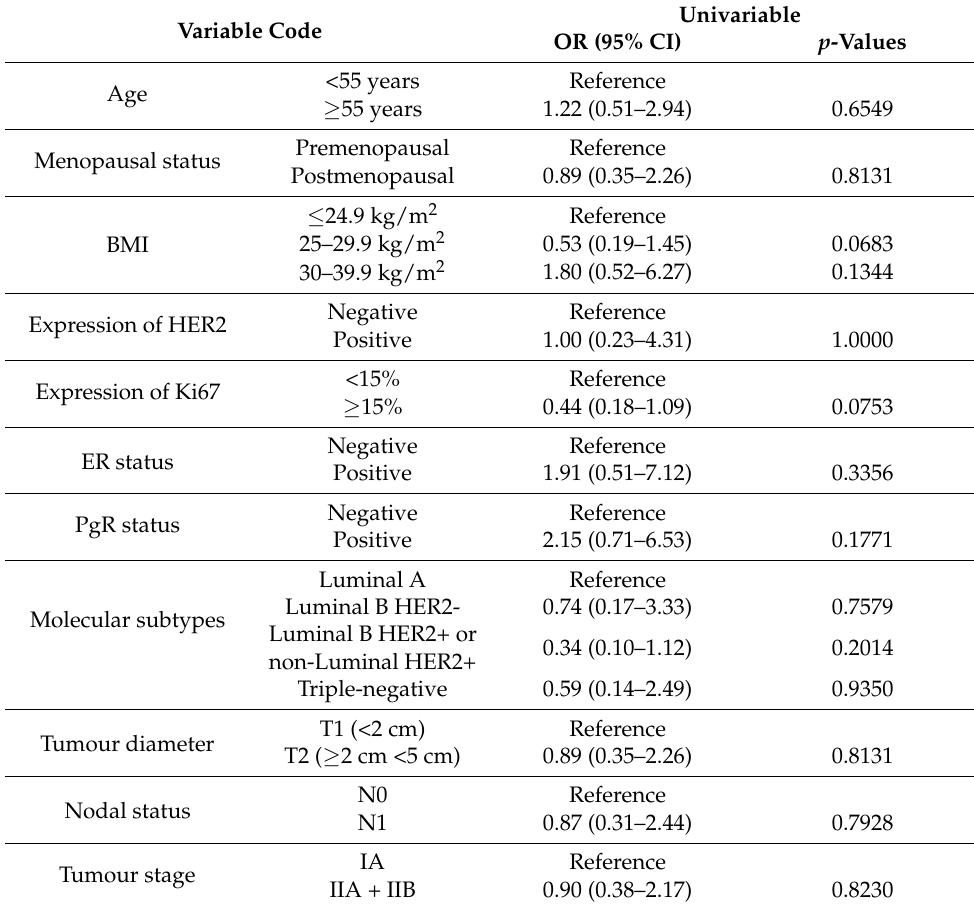
Table 6. Univariate logistic regression analyses of low or high heparanase changes as predictors in breast cancer